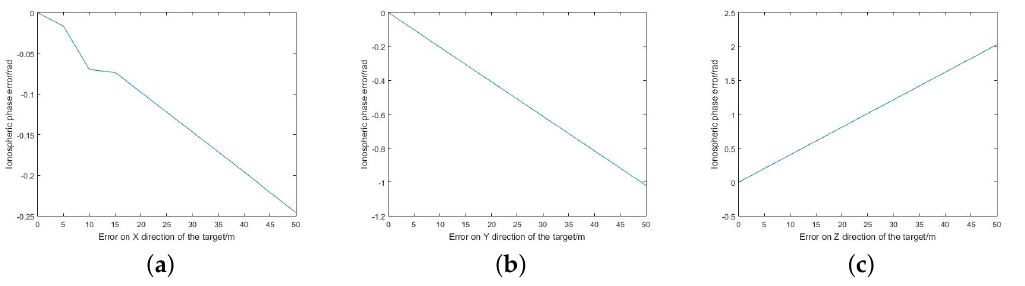
Figure 6. The relationship between error in ionospheric phase and geolocation error on 20100623 and 20100808: ( a ) shows ionospheric phase error when error added in X direction of target coordinate. ( b – c ) are ionospheric phase deviation changing with Y t , Z t .